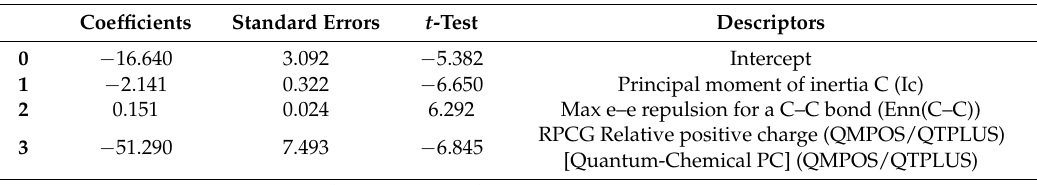
Table 4. Descriptors, Coefficients, Standard Errors, and t -Test Values for the Best MLR Model of Group 3.